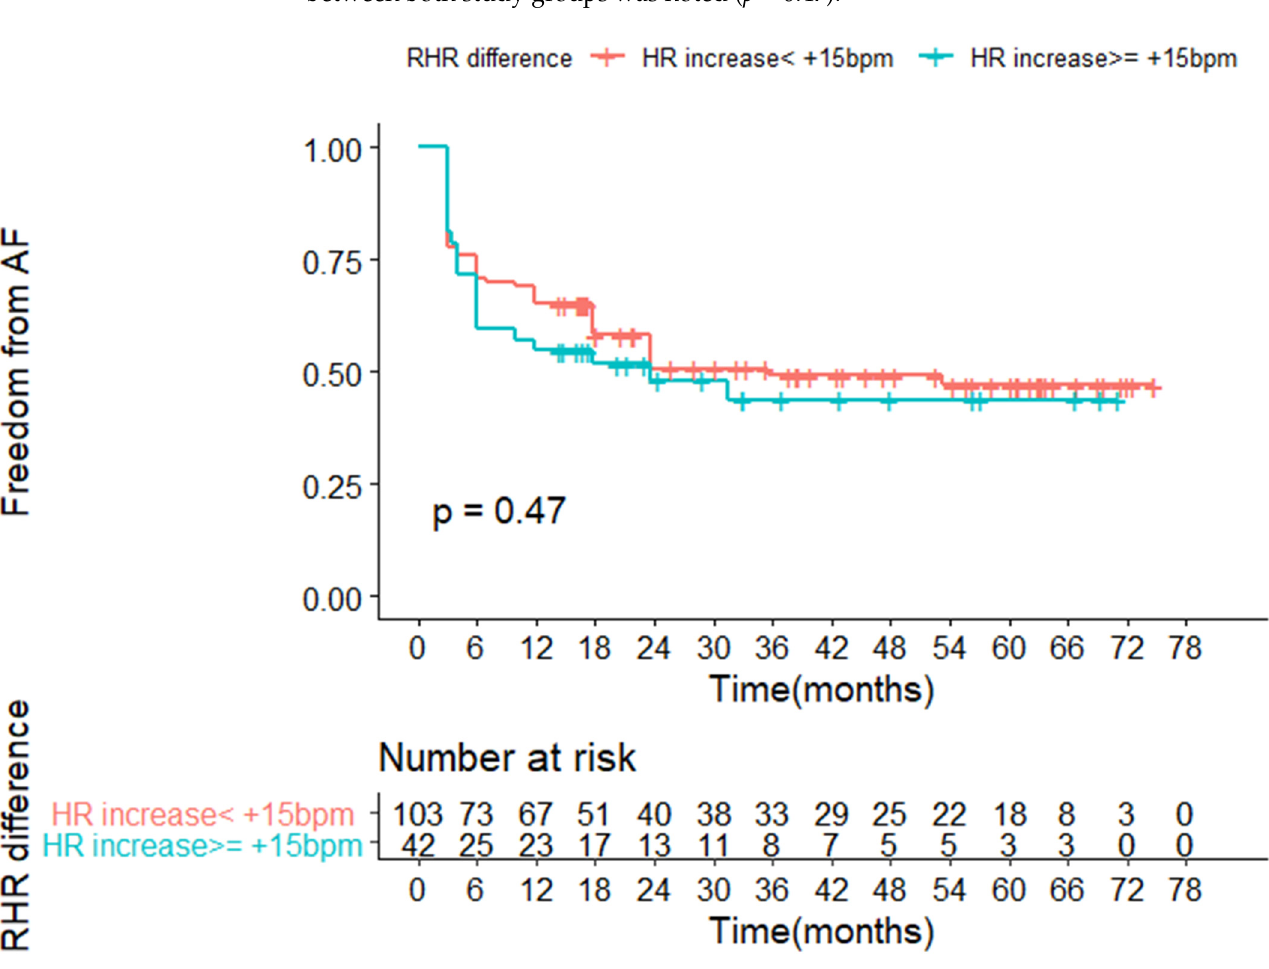
Figure 1. Kaplan–Meier survival curves according to RHR increase of ≥ 15 bpm criterium; freedom from AF recurrence as the end-point.